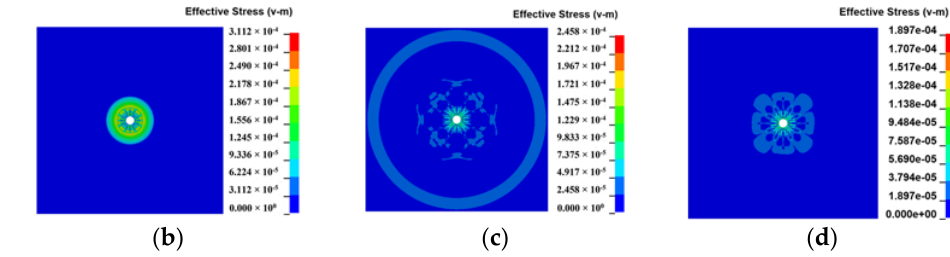
Figure 5. Effective stress nephograms of coal under the action of explosive blasting: ( a ) 15 μ s; ( b ) 30 μ s; ( c ) 100 μ s; ( d ) 200 μ s.